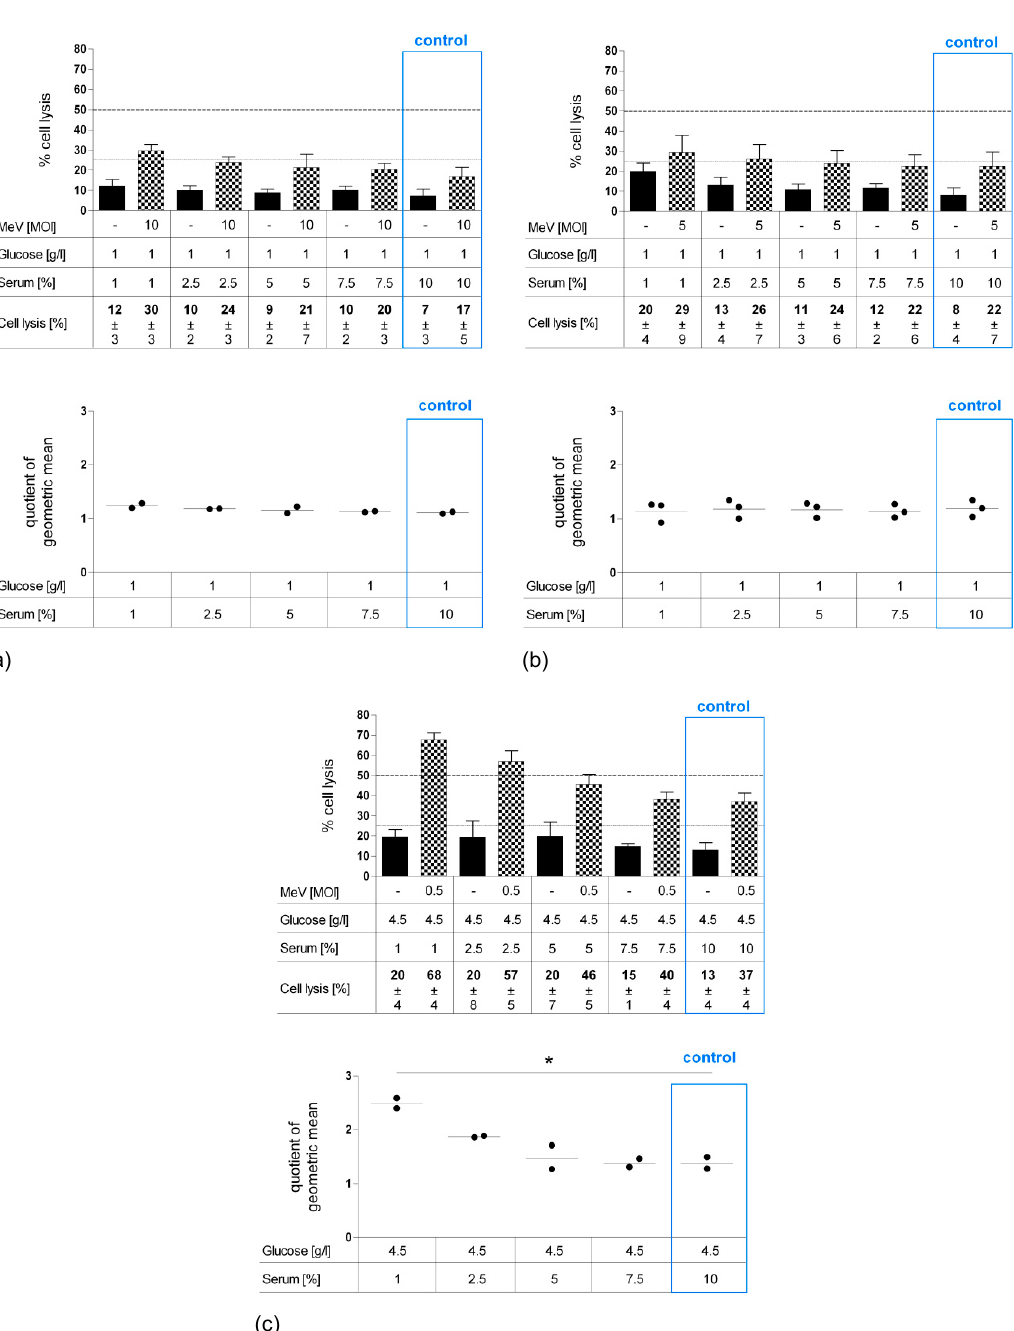
Figure 7. Effect of long-term standard glucose, low-serum starvation on MeV-mediated oncolysis in normal human colon fibroblast cell line CCD-18 Co ( a ) and epithelial cell line CCD-841 CoN ( b ) compared to HT-29 cells ( c ) determined by LDH assay. Cell culture, starvation and infection were carried out as in Figure 6. At 96 hpi, an LDH assay was performed to determine cell lysis. Differences were considered significant when P -values were <0.05 (*).